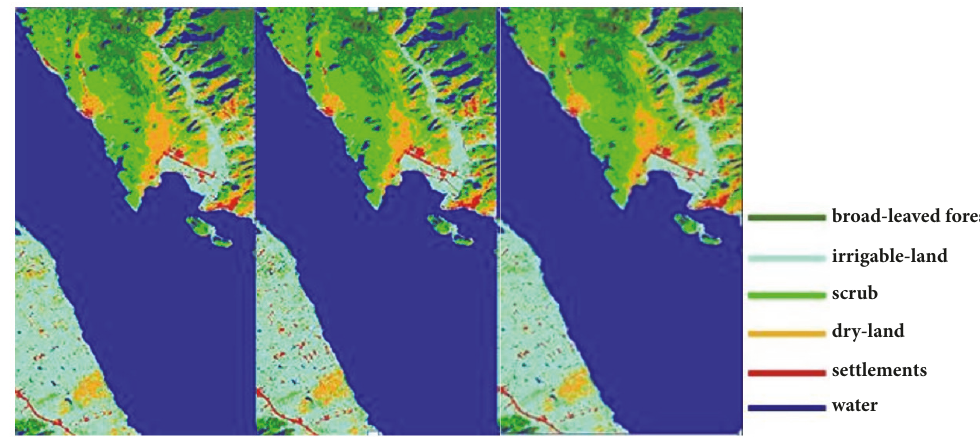
Figure 20: The classification results of support vector machine algorithm for the Hyperion data.